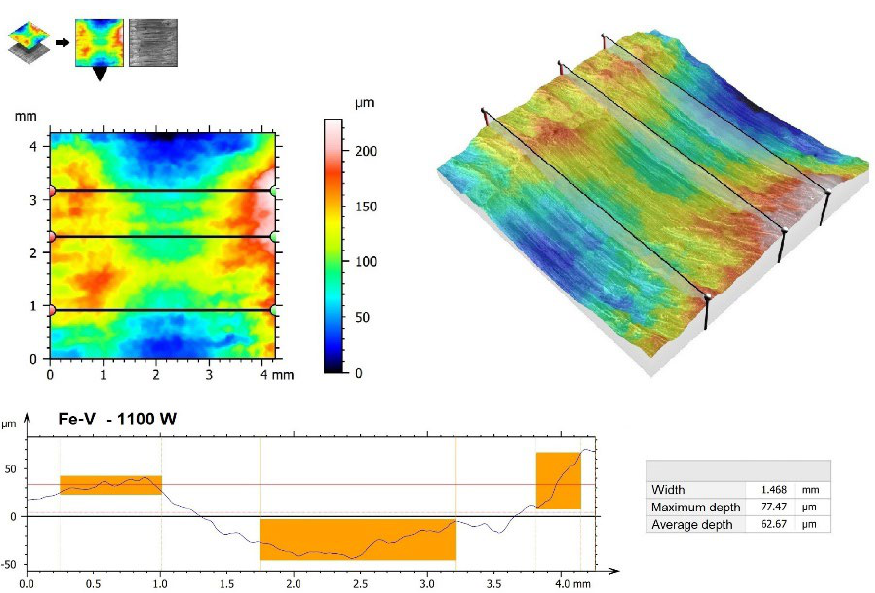
Figure 14. The 3D wear profiles obtained after the wear resistance test of the coating produced by 1100 W.